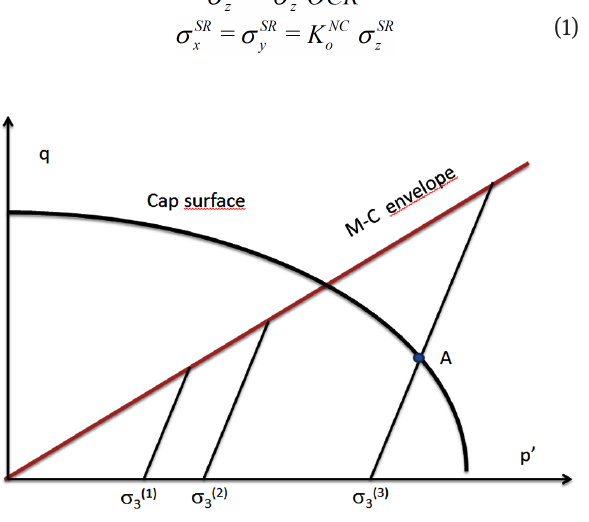
Figure 1: Problem of coupling shear and volumetric plastic mechanisms during triaxial CD test carried out on normally or lightly overconsolidated